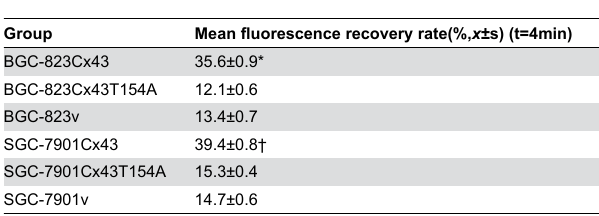
Table 3. Comparison of the mean fluorescence recovery rates after bleaching in BGC-823 and SGC-7901 gastric cancer cells (fluorescence intensity, x